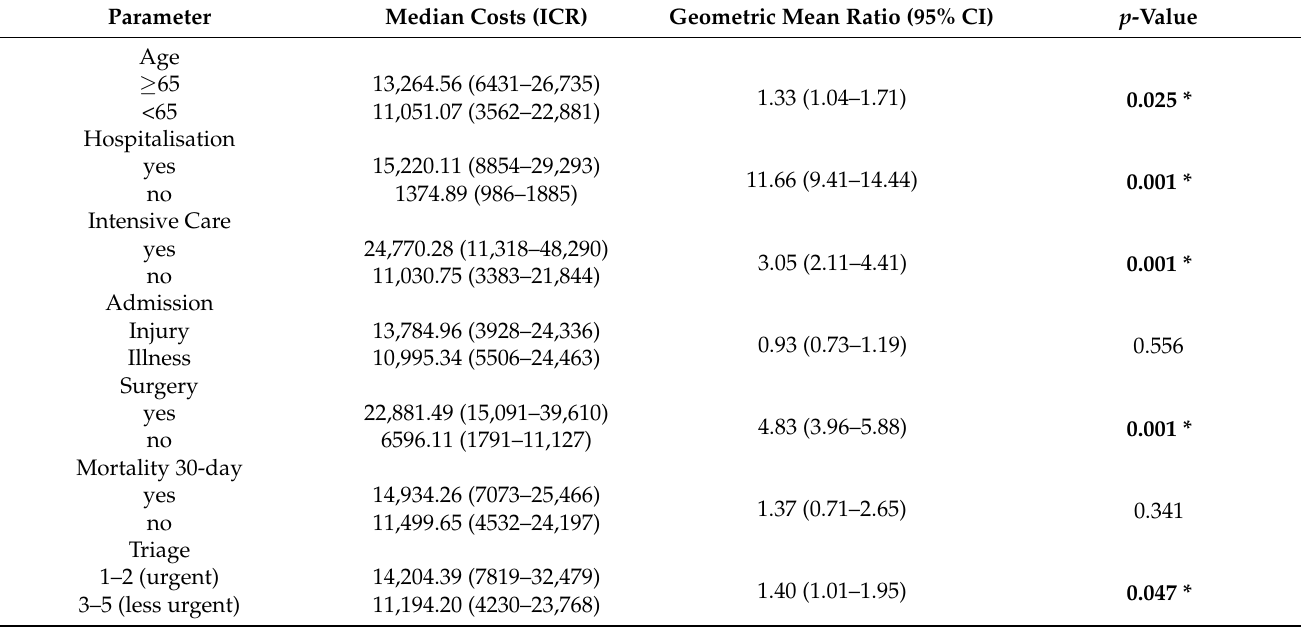
Table 4. The association of outcome parameters with total case costs (univariate linear regression). Results of log transformed linear regression, expressed as geometric mean ratio.